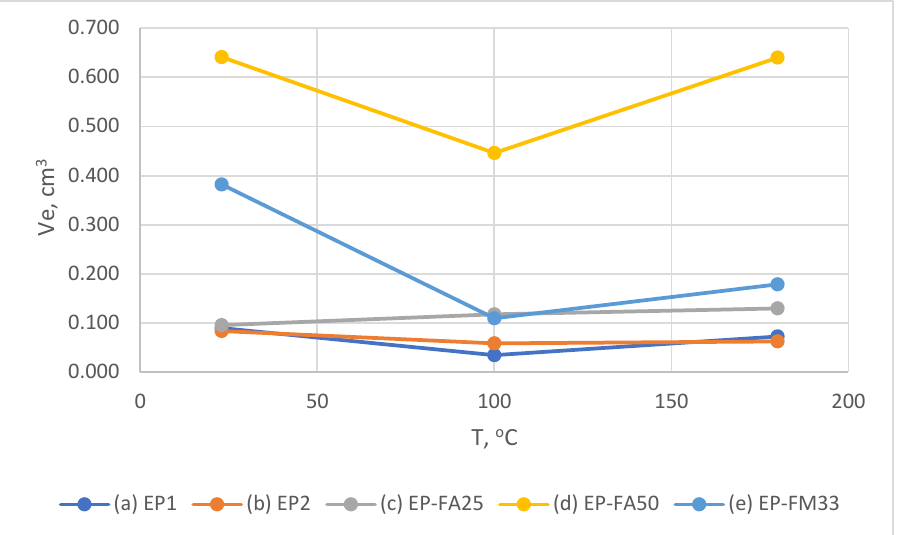
Figure 8. Dependence of the wear of unfilled and filled compounds on the temperature at an impingement angle of 90°.